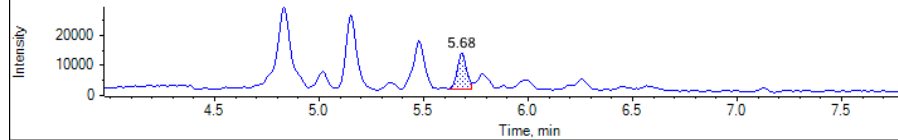
Figure 9. Chromatogram of pistachio kernel sample contaminated with HT-2 toxin (HT2). Fumonisin B1 was detected in one pistachio kernel and shell from USA, but at a concentration lower than the LOQ (25 µ g/kg). However, no limits are established for fumonisins in nuts. Fumonisins are produced by Fusarium proliferatum and F. verticillioides , and predominantly found in corn and derived products [56]. the last 2 decades show contamination with FBs, ZEA, T2 or HT2.